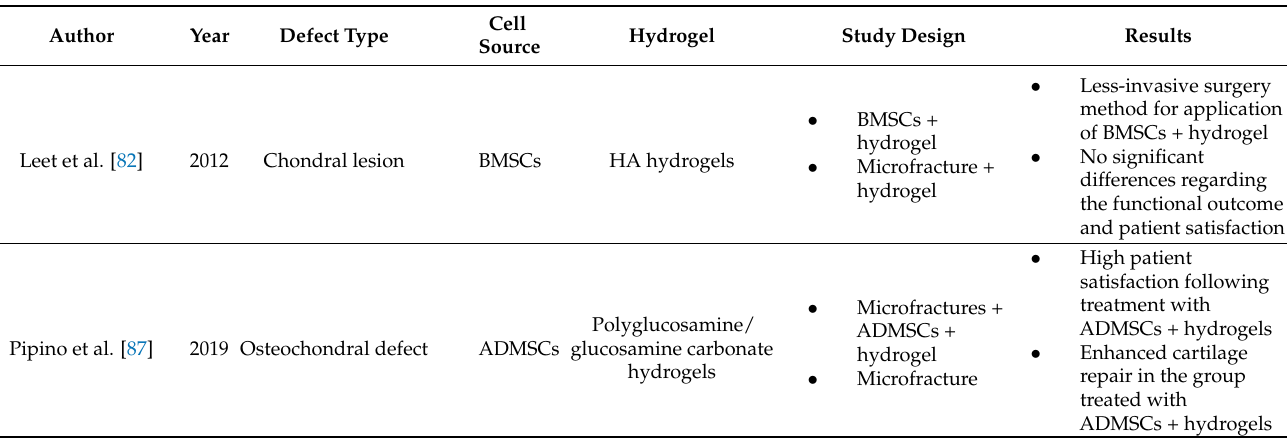
Table 3. Clinical studies examining the use of MSC-laden hydrogels for cartilage